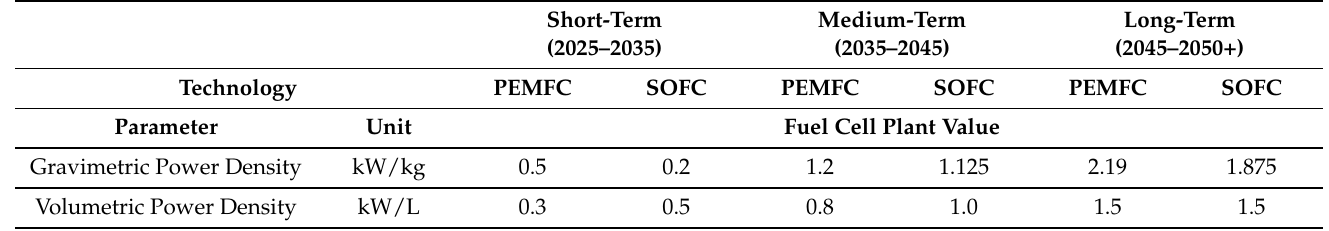
Table 6. Gravimetric and volumetric power density of fuel cell systems across different time